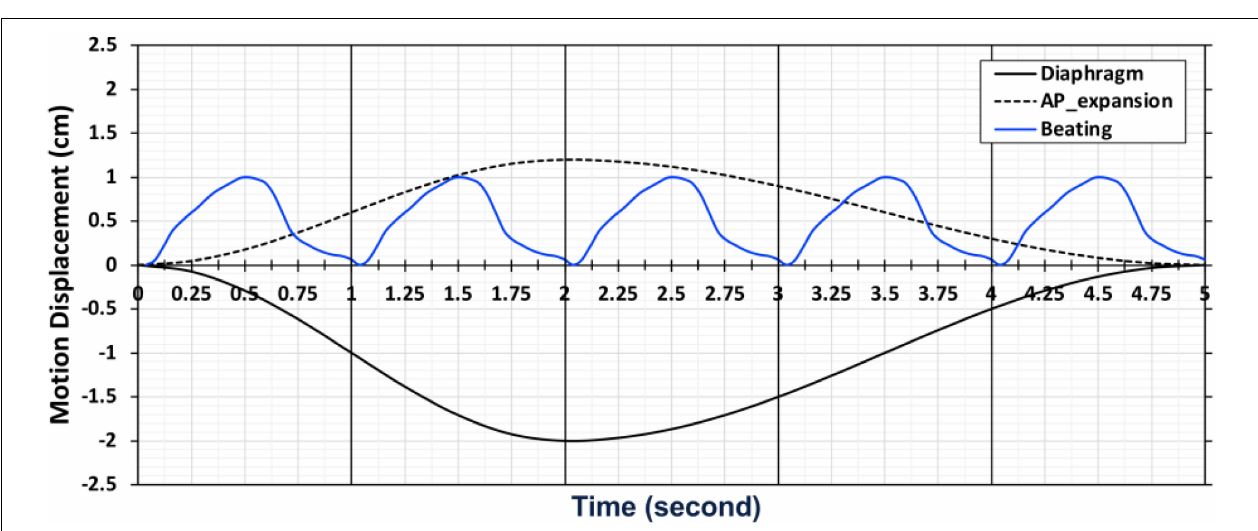
FIGURE 1 | The 4D XCAT whole-body phantom (A) was cropped and simplified to model a cardiac torso (B) . The torso was then imported to a SPECT system geometry (C) with collimator (gray), detector crystal (yellow), back-compartment (white) and lead-shields (blue and green). Also shown are the rear (D) and side (E) view of the detector.